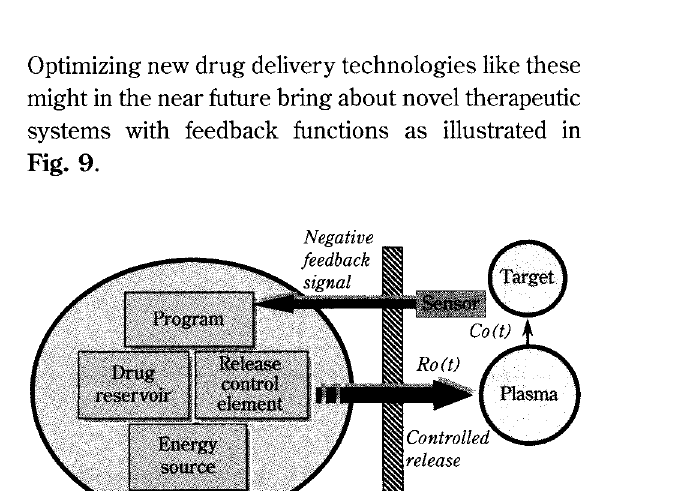
Advanced drug delivery system with negative feedback control loop. Feedback signal may be the concentration of bioinformation molecules extracted from the